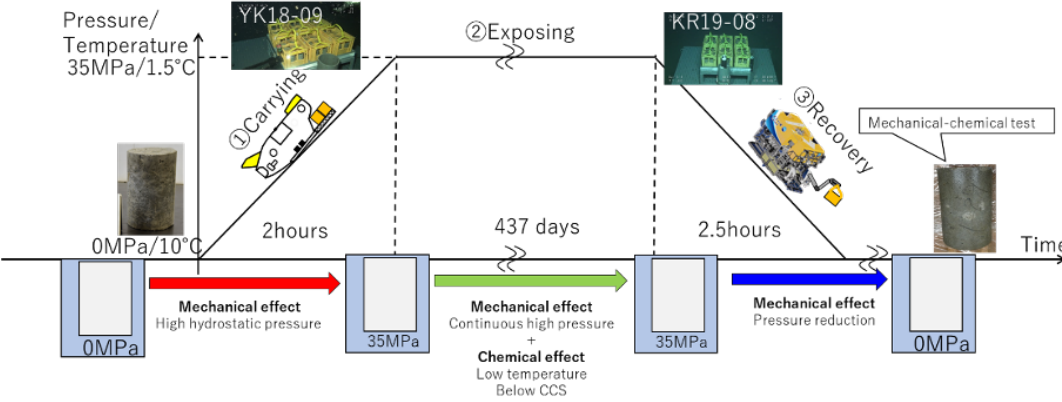
Figure 11. Conceptual representation of the physical and chemical environments around in the concrete